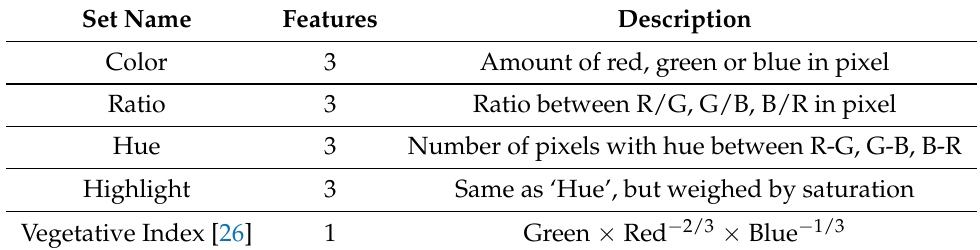
Table 1. Description of the 13 investigated features for the MVR